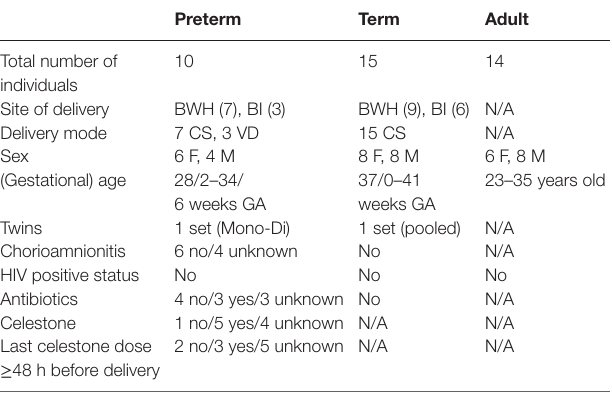
TaBle 1 | Characteristics of human preterm, term, and adult study